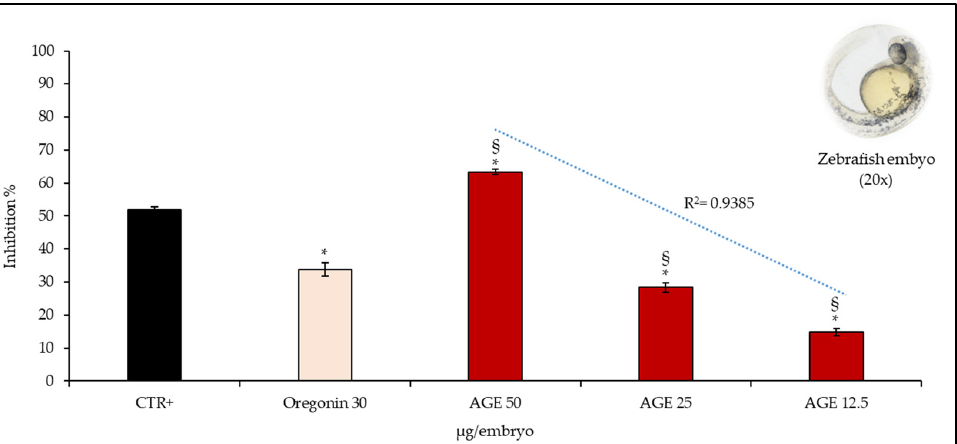
Figure 5. Anti-angiogenic properties of several concentrations of A. glutinosa bark extract (AGE, 12.5–50 µg/embryo) evaluated by EAP activity of vascular endothelial cells released from treated zebrafish embryos, of which a representative micrograph (magnification 20×) was reported. Results were expressed as mean inhibition percentage ± standard deviation of five independent experiments ( n = 5). * p < 0.01 vs. positive control (CTR+), 2-methylestradiol 30 µg/embryo; § < 0.001 vs. oregonin 30 µg/embryo.